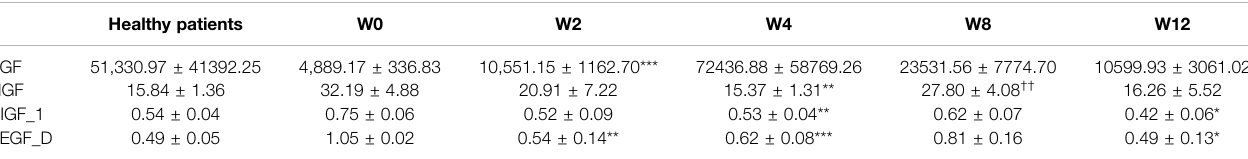
Frontiers in Pharmacology |